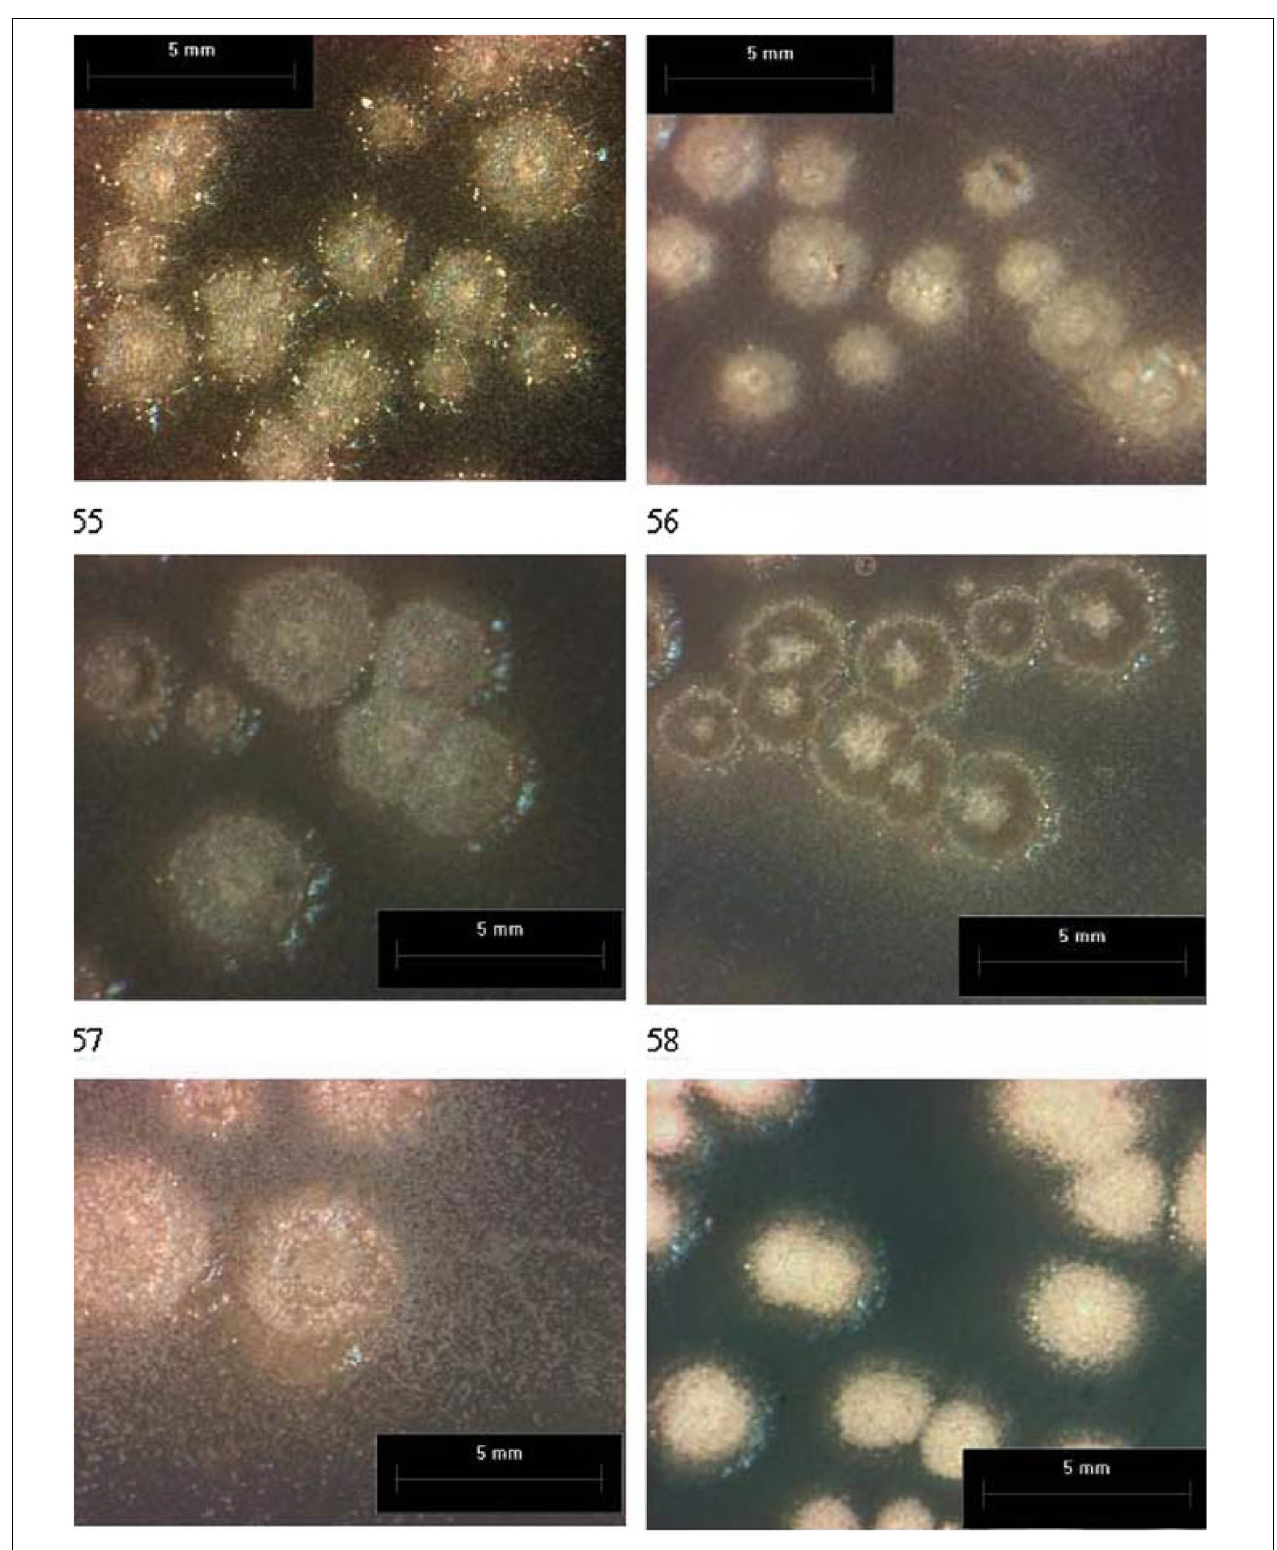
FIGURE 2 | Colonies of 6 different strains of B. sphaericus and B. lentus on agar plates and their ability to encrust themselves in calcium carbonate (Source: Dick et al., 2006).